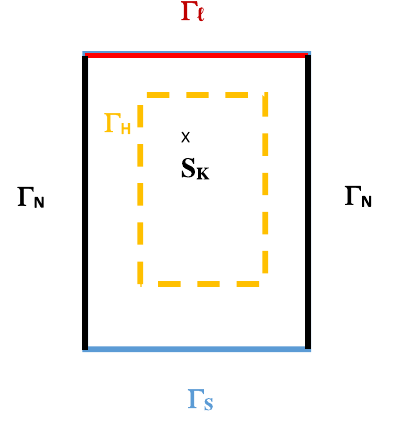
Figure 1. Domain